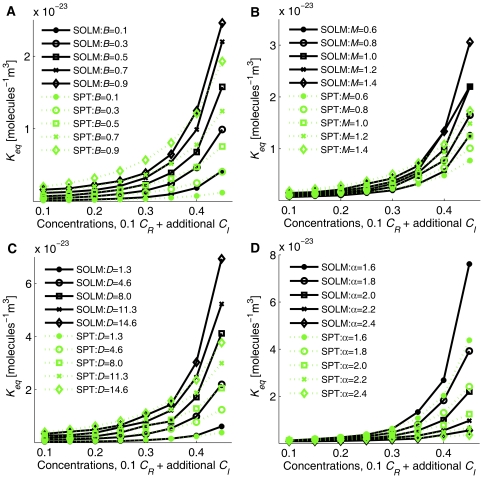

Keq estimated from SOLM and SPT for fixed 0.1 CR+ additional CI and varying parameter values (B, M, D, α).(A) Variation across five B values (0.1 bottom, 0.3, 0.5, 0.7, 0.9 top), (B) Variation across five M values (0.6 bottom, 0.8, 1.0, 1.2, 1.4 ns top), (C) Variation across five D values (1.3 bottom, 4.63, 7.97, 11.3, 14.63×10−11 m2s−1 top), (D) Variation across five α values (1.6 top, 1.8, 2.0, 2.2, 2.4 bottom). All other parameter values for each test are set to their default values: B = 0.7, M = 1.0 ns, D = 4.63×10−11 m2s−1, α = 2.0, β = 1.0, and dth = 0.125 nm in a 50 nm×50 nm×50 nm simulation box.